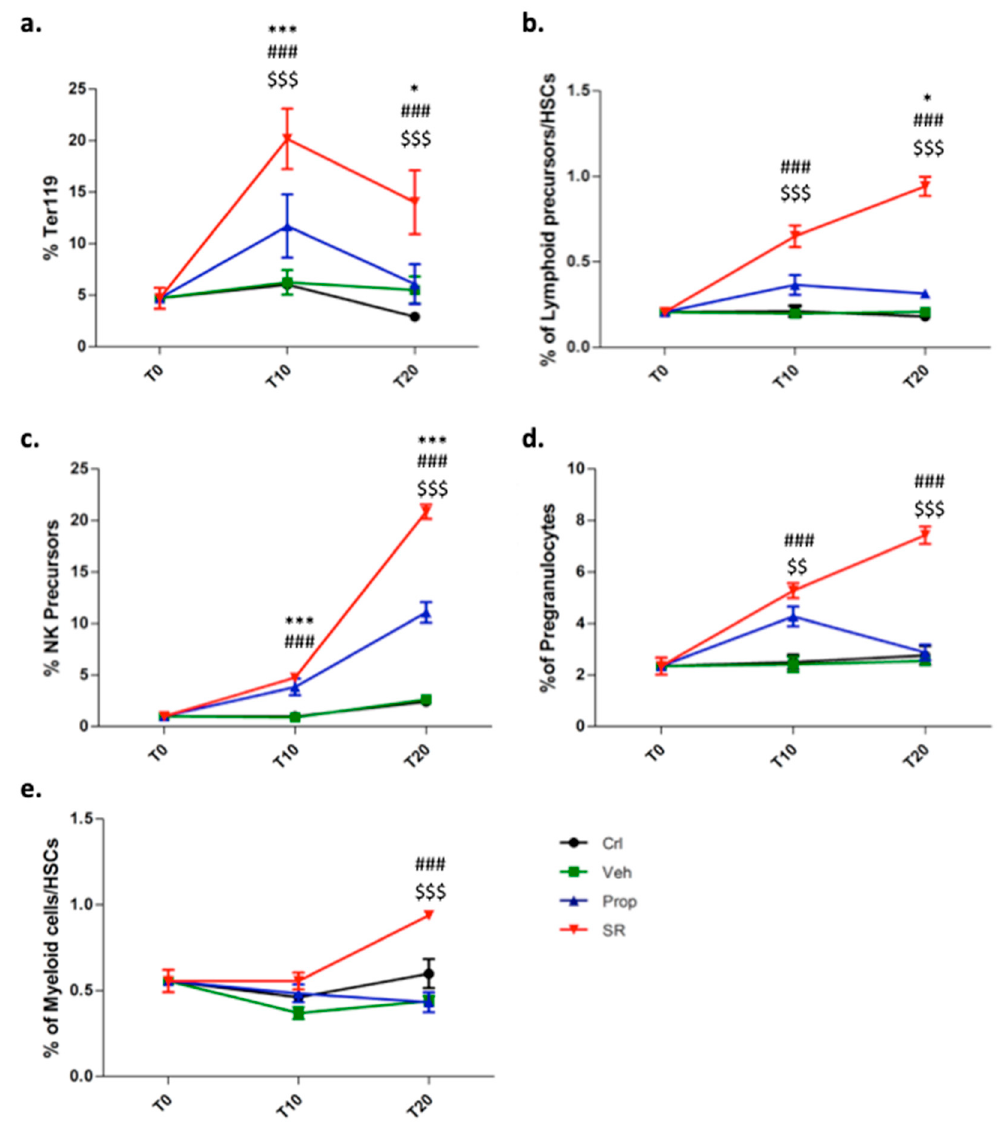
Figure 3. FACS analysis and relative quantification of: ( a ) Ter119 gated on CD45 - cells at T0, T10, T20. ( b ) Lymphoid precursors (SCA1 + gated on CD117 + , CD127 + , Lin − ) / HSCs ratio at T0, T10, T20. ( c ) Natural killer (NK) precursors (NK1.1 − gated on CD122 + , Lin − ) at T0, T10, T20. ( d ) Pre-granulocytes (CD127 − , CD16 / 32 + gated on CD117 + , SCA1 − , CD34 + , Lin − ) at T0, T10, T20. ( e ) Myeloid (SCA1 − gated on CD117 − , CD127 + , Lin − )/HSCs ratio at T0, T10, T20.